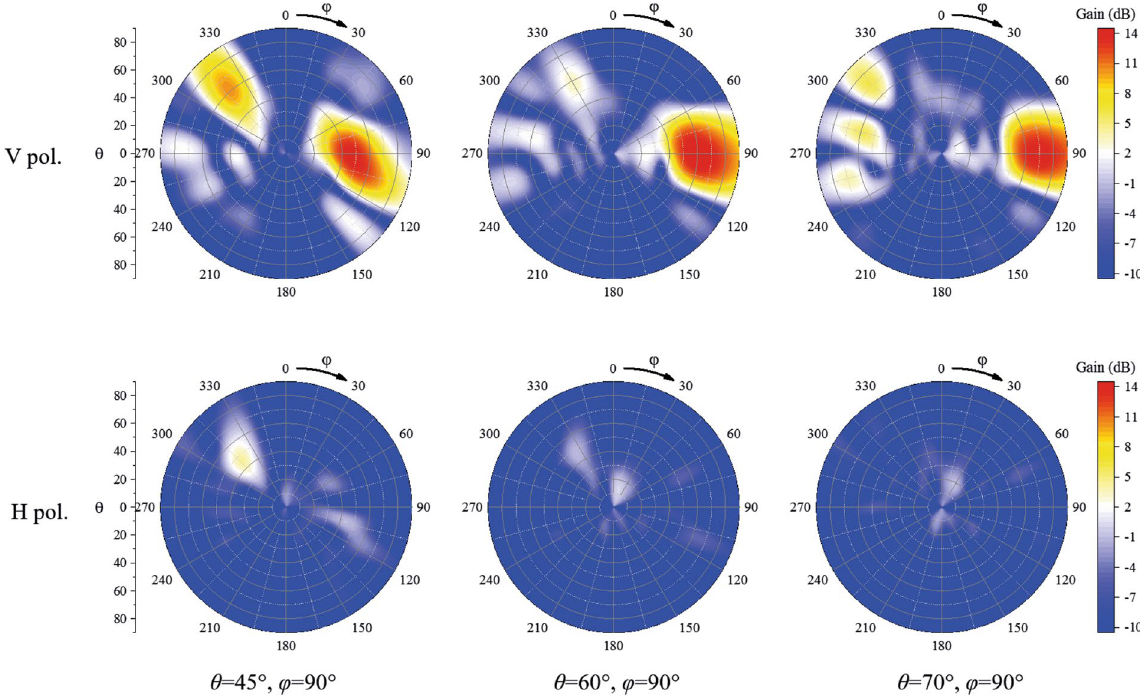
Figure 12. Simulated patterns of the array scanning in θ directions at 5.8 GHz. The H pol. and V pol. represent the horizontally polarized component and vertically polarized component, respectively.